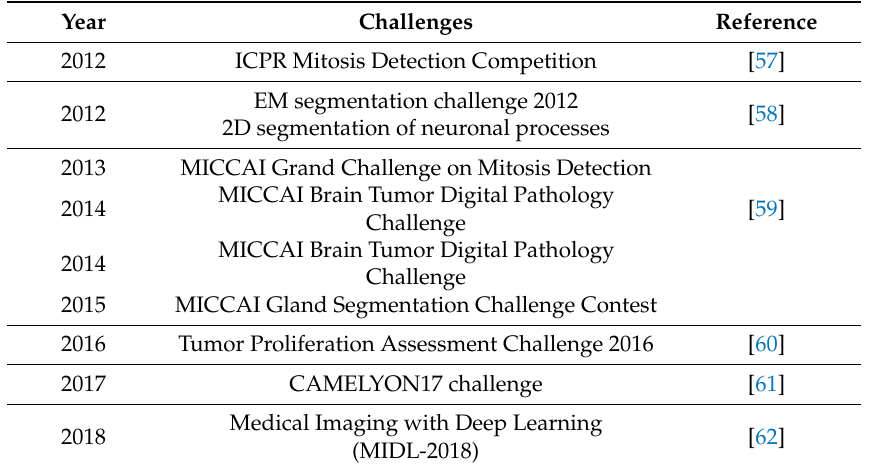
Table 3. Overview of some open challenges in digital pathology images analysis